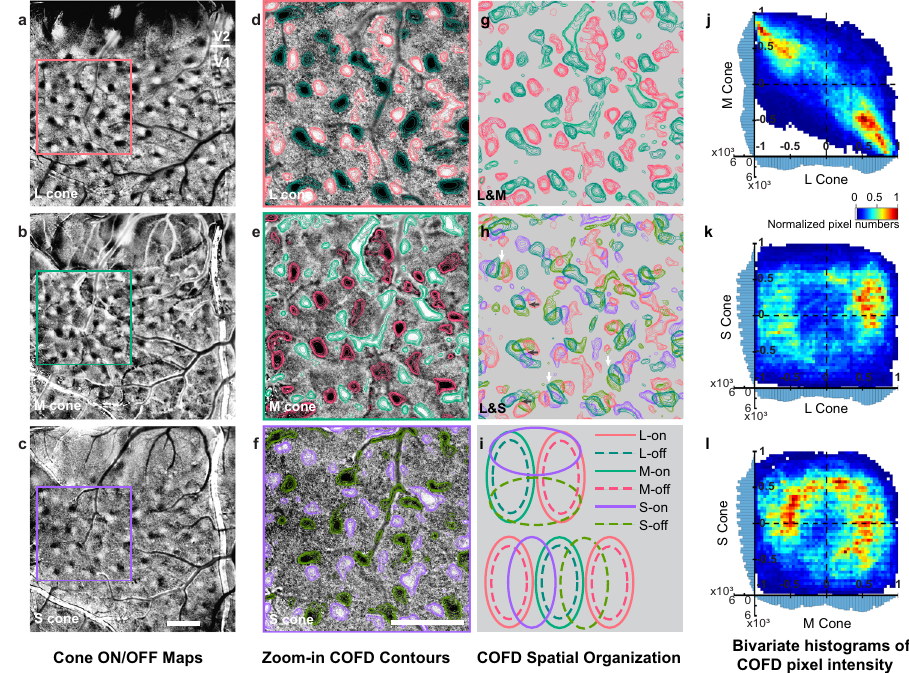
Fig. 4 | Spatial relationships between L-, M-, and S-COFDs. a – c COFDs from ISI phase maps in response to full- fi eld periodic L-, M-, and S-cone-isolating stimuli, respectively.Scalebarin c :1mm;appliesto a – c . d – f Zoom-inviewsofmapsin a – c . Color contours for ON and OFF domains are overlaid on images based on ISI pixel values.Scalebarin f :1mm;appliesto d – h . g MergedimageofL-COFDcontours( d ) with M-COFD contours ( e ). Same scale as f . h Merged image of L-COFDs ( d ) with S-COFDs ( f ). Same scale as f . Additional examples are shown in Supplementary Fig. 2a. L- and M-COFDs overlap extensively with an anti-phase relationship; L-on COFDsalignwithM-off COFDs,and L-offalignwithM-on( g ,alsosee j ).Incontrast, S-ON and S-OFF COFDs tend to fall between and partially overlap with L+M − and